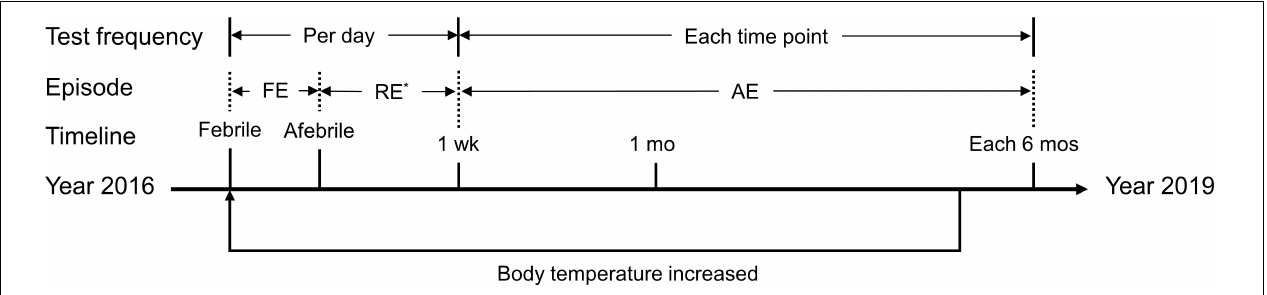
FIGURE 2 | Timeline of the episodes and tests described in the present study. FE, febrile episode; RE, recovery episode; AE, afebrile episode; wk, week; mo, month. *Not available in some days during this period. The axis indicates the timeline from the year 2016 to the year 2019. The phrase “body temperature increased” indicates a round of hearing fluctuation due to a febrile episode. During the follow-up period, the proband experienced three febrile episodes, whereas each of the other three patients experienced only one. Tests were completed at each time point during each febrile